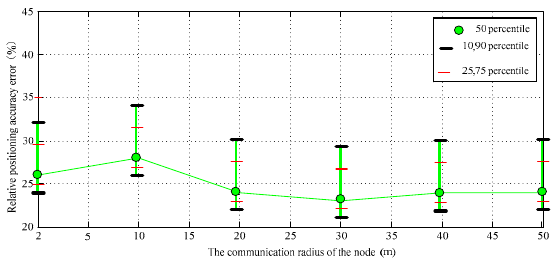
Figure 10. The confidence interval of the data II.